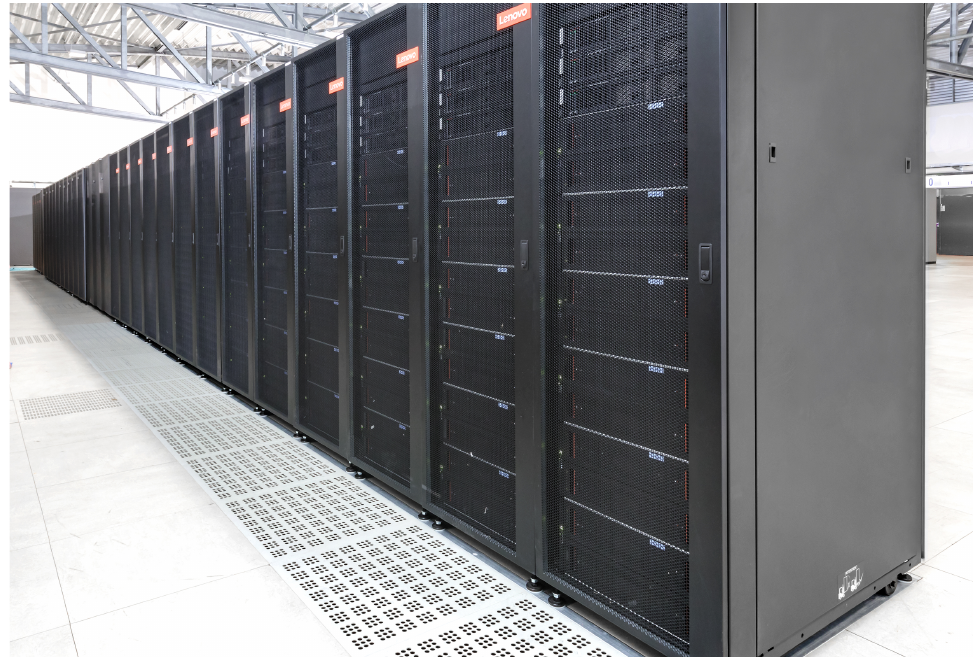
Figure 1: Disk-arrays in the storage cluster JUST in the facility of Jülich Supercomputing Centre. Copy- right: Forschungszentrum Jülich